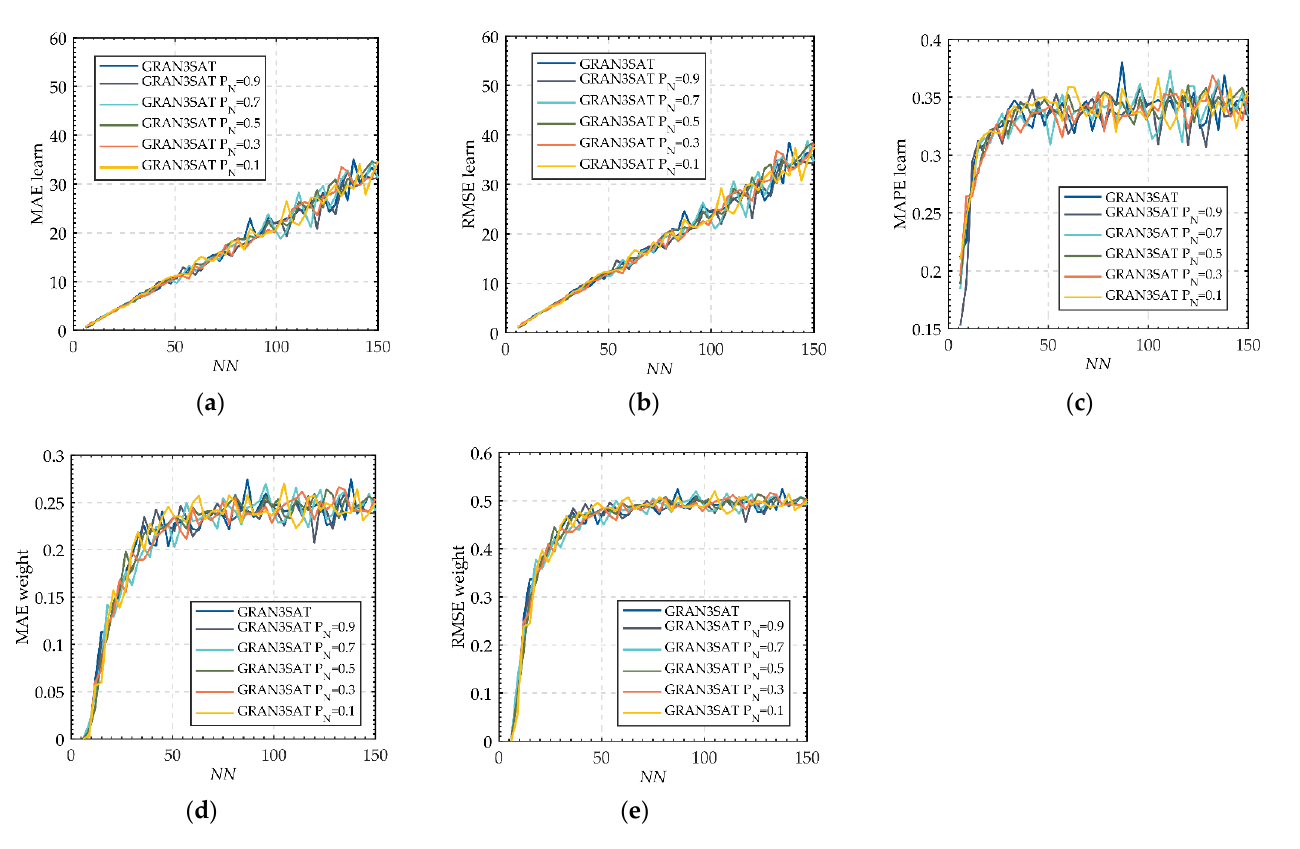
Figure 6. Error performance for ( a ) MAE learn , ( b ) RMSE learn , ( c ) MAPE learn , ( d ) MAE weight , and ( e ) RMSE weight Table 10. The slopes of the straight-line fit of the error metrics.